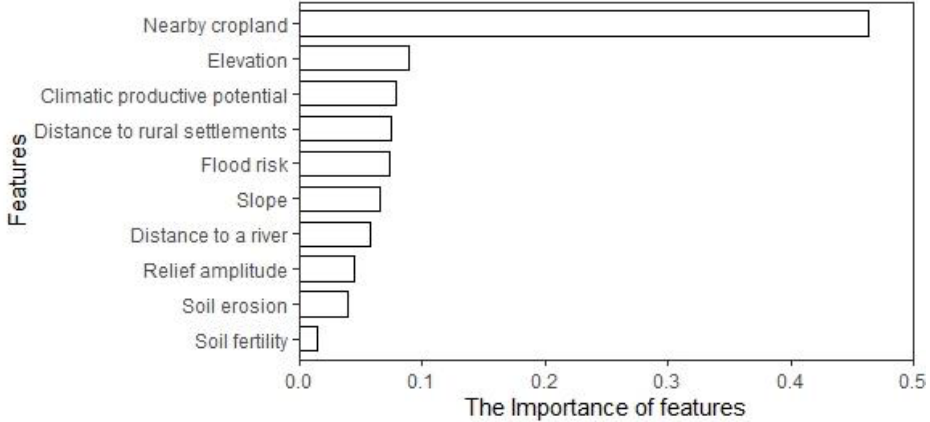
Figure 12. The feature importance values for the independent variables.